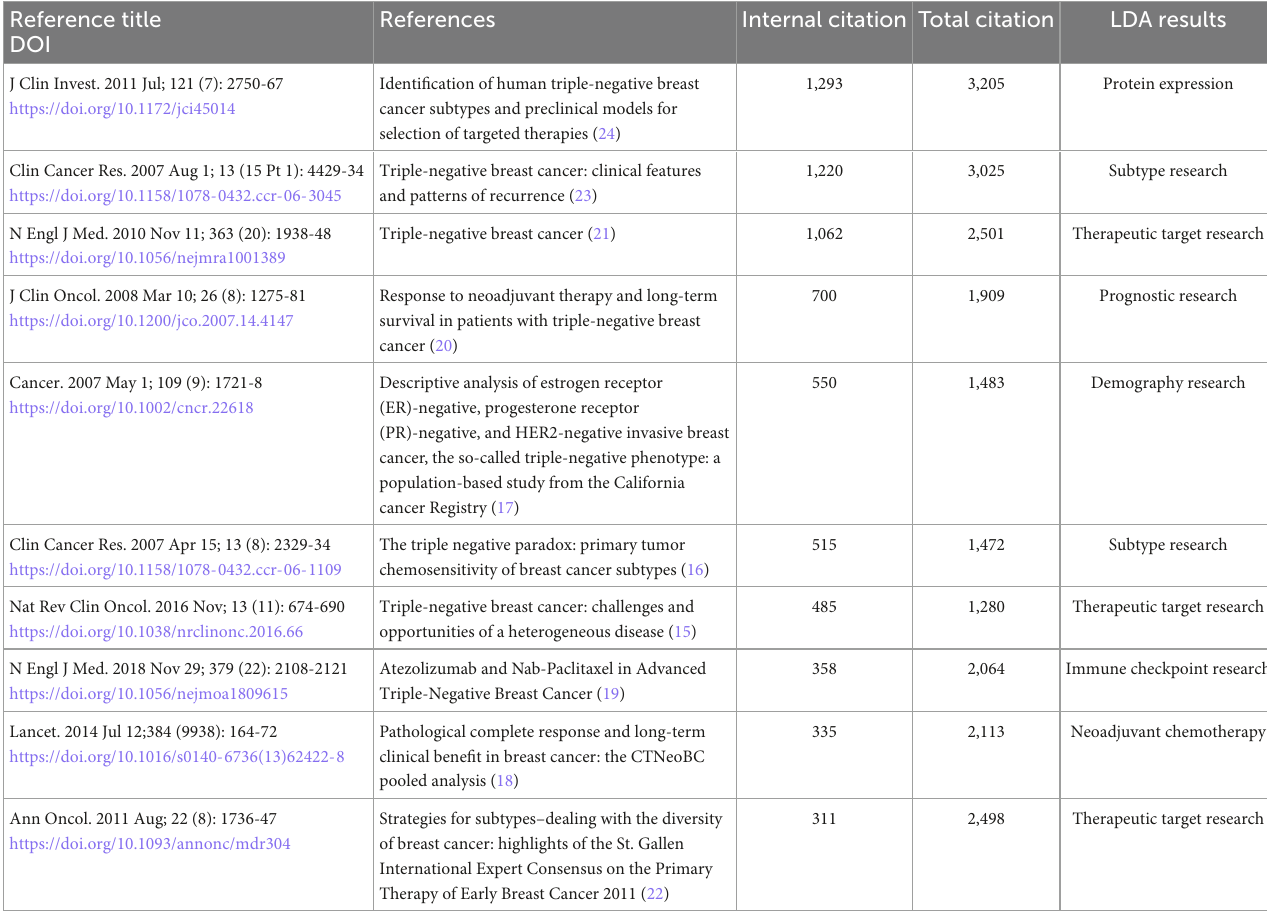
TABLE 3 Top 10 publications of triple-negative breast cancer (TNBC) based on internal citations and Latent Dirichlet Allocation (LDA)